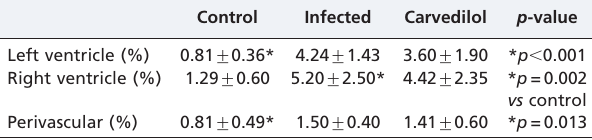
Table 1 - Collagen volume fraction in the interstitial and perivascular space in the left and right ventricles. Control Infected